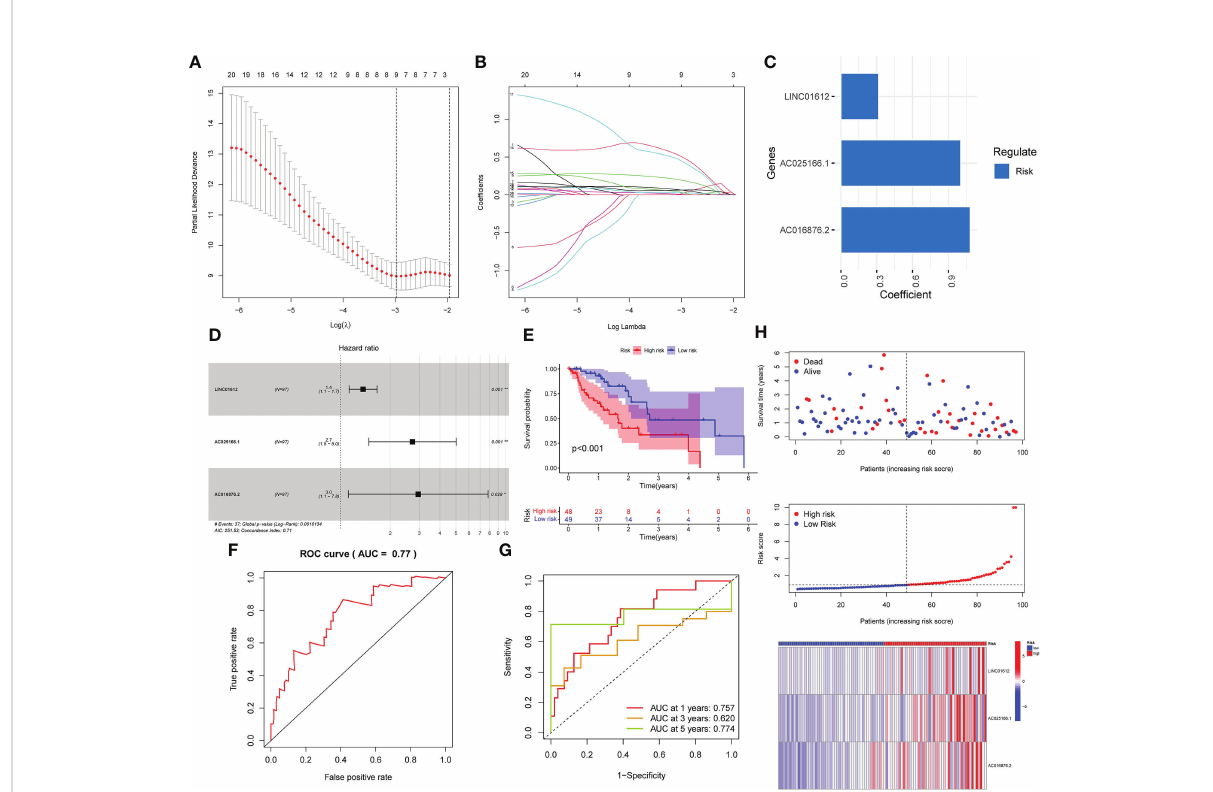
FIGURE 1 Development of a prognostic risk model based on the expression of three lncRNAs associated with m6A in the training set. (A – C) Three lncRNAs associated with m6A were identi fi ed by LASSO Cox regression analysis. (D) Forest plot of three m6A-related lncRNAs. (E) K-M survival curves uncovered that EC patients in the low-risk subgroup in the training set possessed a better OS. (F) Prognostic signatures in the training set were analyzed using ROC curves to determine their predictive capacity. (G) The prediction ef fi ciency of the prognostic risk model for 1 year, 3 years, and 5 years was determined through ROC curve analysis. (H) Survival status scatter plot. The distribution of risk scores and the expression pro fi le heatmap of three m6A-associated lncRNAs in the training set are shown. *p< 0.05; **p< 0.01; ***p<